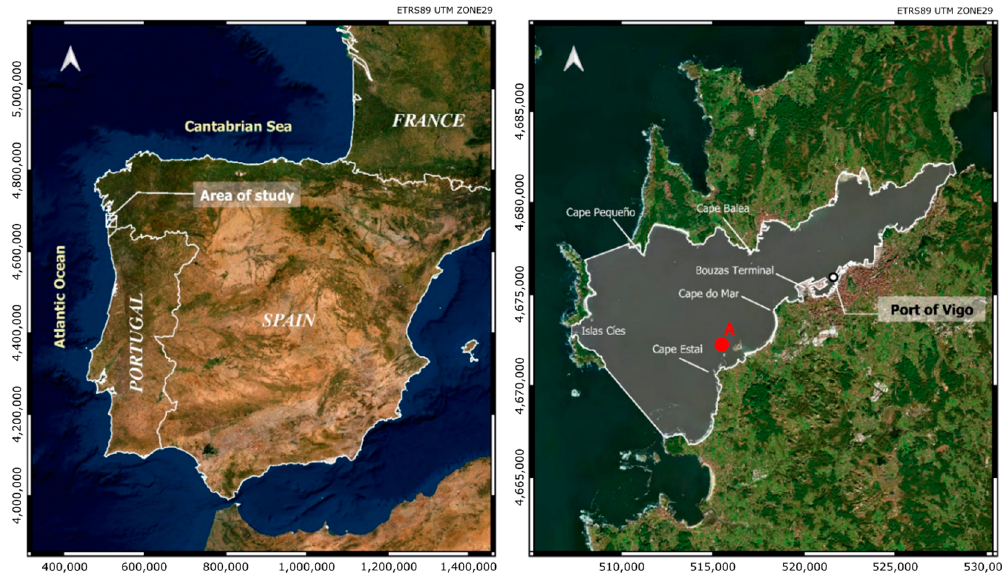
Figure 1. Location of the area of study ( left ) and detail of the Port of Vigo and the point of interest (Point A) ( right ).